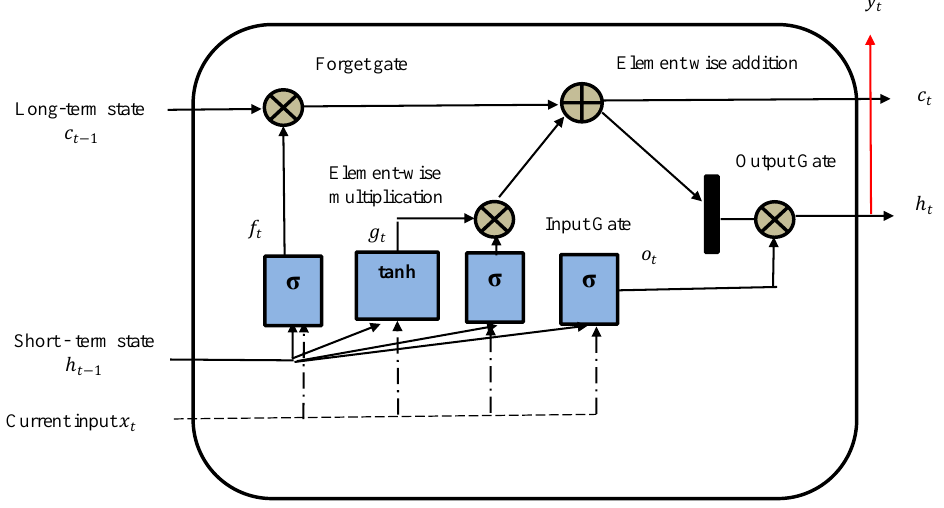
Figure 4. LSTM architecture .